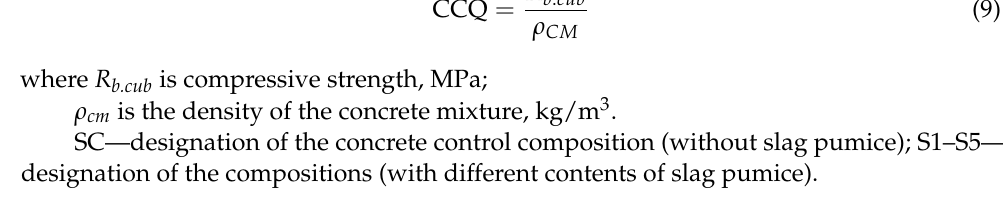
Table 9. Test results of concrete with different contents of porous